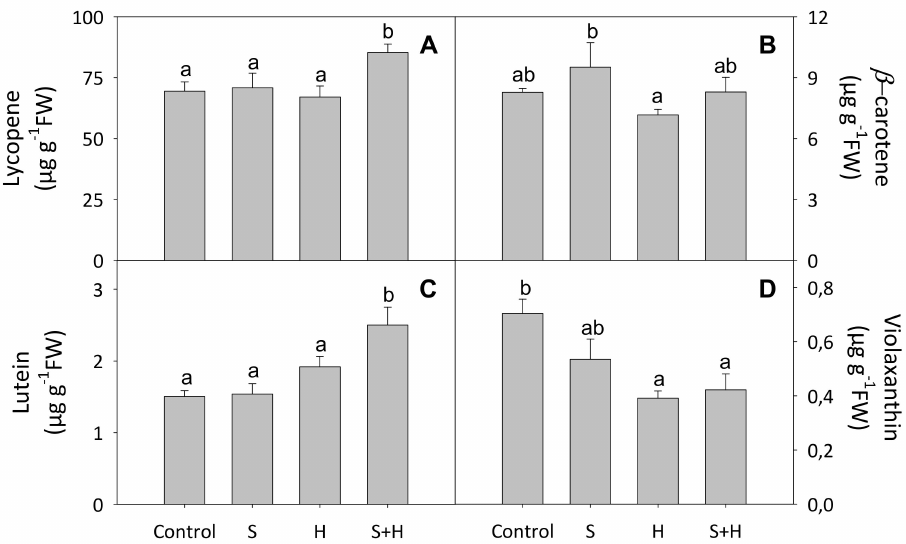
Figure 7. Concentration of lycopene ( A ), β -carotene ( B ), lutein ( C ) and violaxanthin ( D ) ( µ g g − 1 fresh weight) in tomato fruits under control (C), saline (S) and heat conditions (H) or the combination of salinity and heat (S + H). Values are means ± SE ( n = 6). Different letters indicate significant differences between means according to Duncan’s test at the 5%